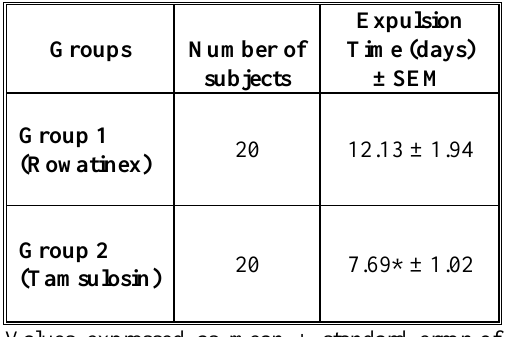
Values expressed as mean + standard error of mean.